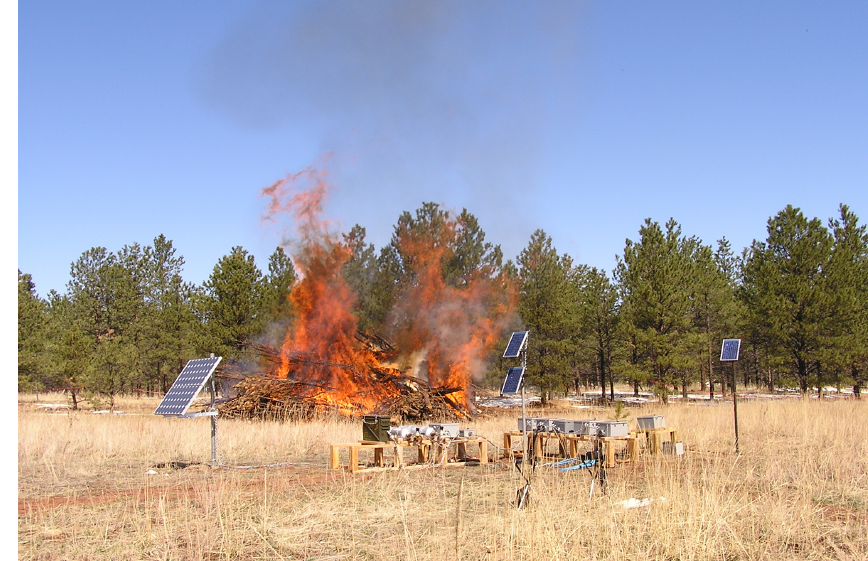
Figure 2. Layout of the data system and slash pile of the MEF 26 April 2004 experimental burn about 25min after ignition. Image credit: John M. Frank.